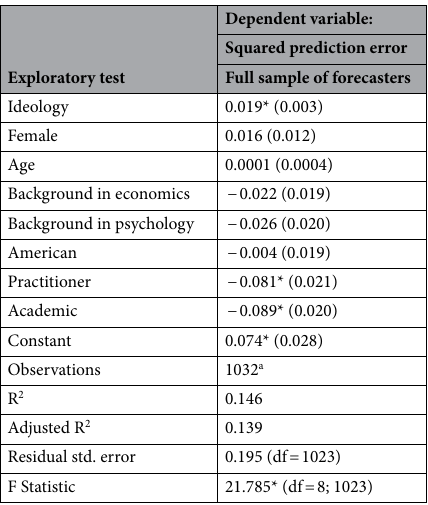
Table 3. Individual level regression of the prediction error on forecaster characteristics. *p < 0.05. a Two forecasters didn’t provide information on their political ideology and were dropped from the